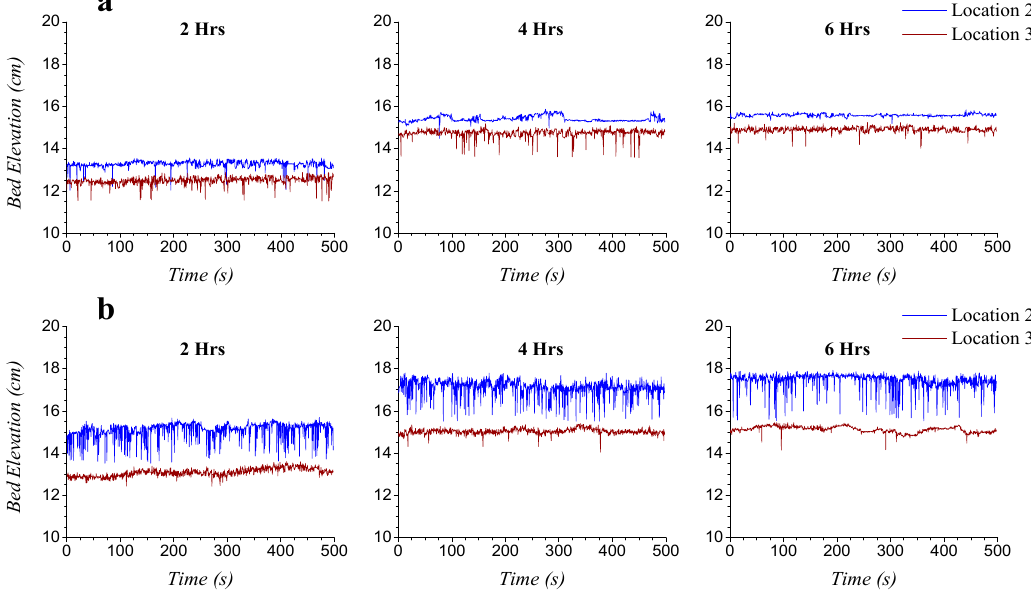
Figure 11. Bed elevation time series of scour depth (upstream and downstream) of P 1 for ( a ) no pit and ( b ) with pit cases.